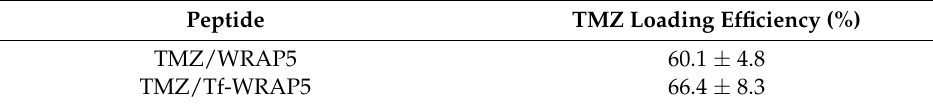
Figure 1. HPLC chromatogram for TMZ standard sample at 20 µ g/mL ( A ), TMZ/WRAP5 at 20 µ g/mL ( B ) and TMZ/Tf-WRAP5 at 20 µ g/mL ( C ); retention time (TMZ) of 3.4 min. Table 1. TMZ-loaded peptides efficiency.